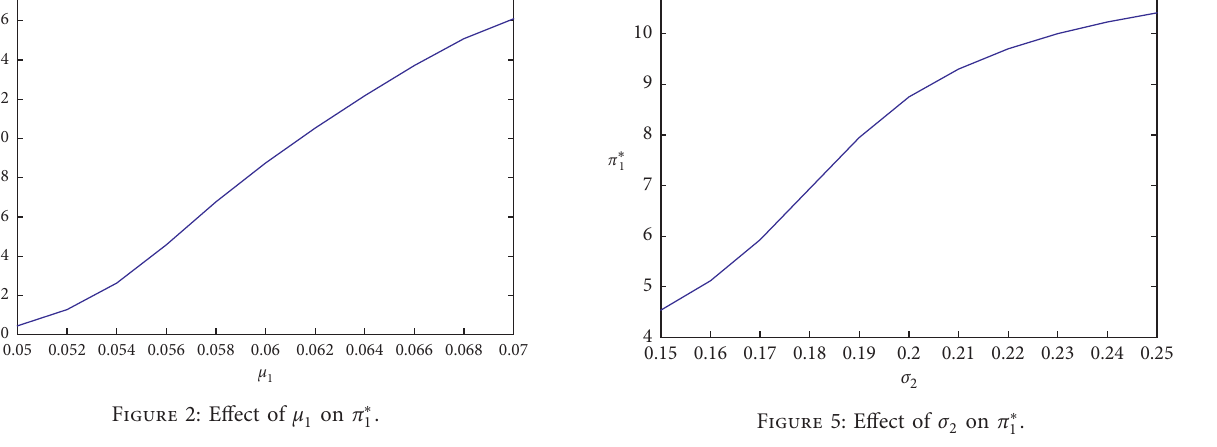
Figure 5: Effect of σ